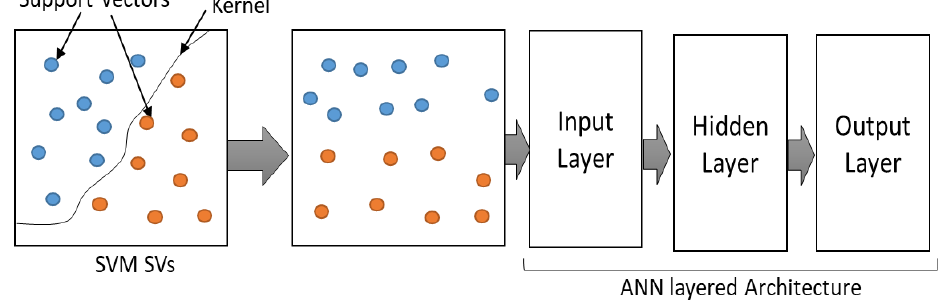
Figure 12. Information flow in ML model.